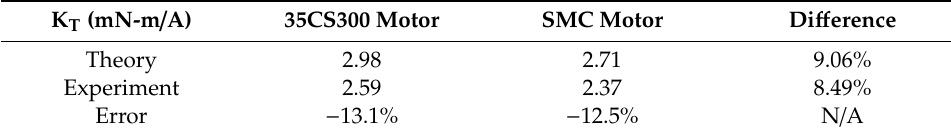
Table 6. Comparison of torque constants (K T ) of 35CS300 and Somaloy 700 1P motors.